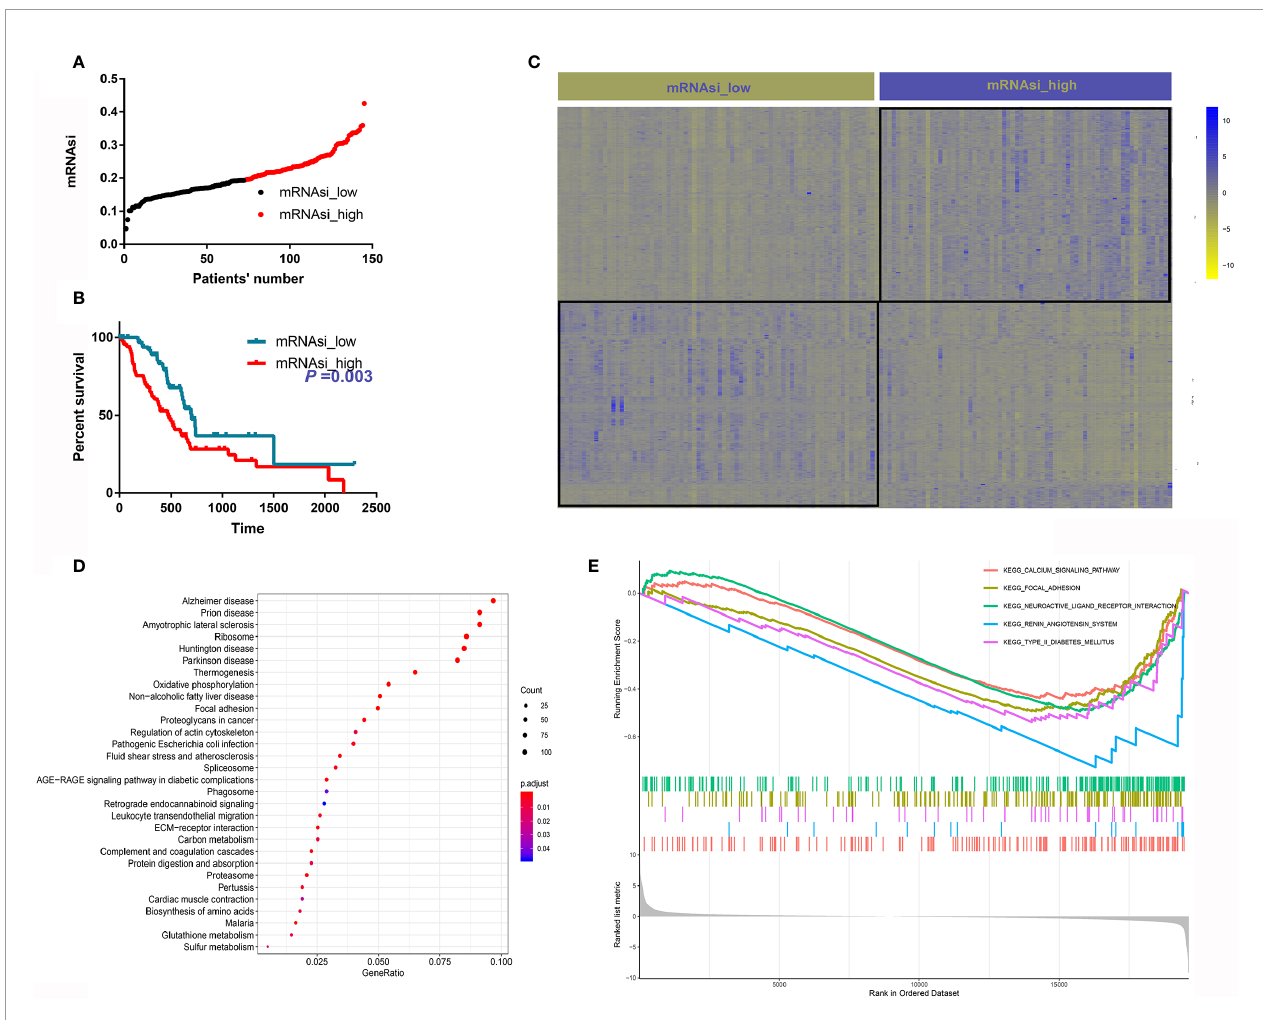
FIGURE 1 | mRNAsi is associated with PDAC patient survival and oncogenic and metabolic pathways. (A) Patients were divided into two groups based on the median mRNAsi. (B) High mRNAsi values predicted poor OS of patients with PDAC. (C) DEGs between samples with high and low mRNAsi values. (D) KEGG analysis of the DEGs. (E) The top fi ve pathways upregulated in samples with high mRNAsi